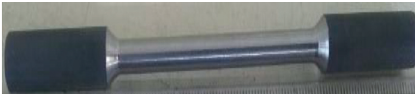
Figure 6: The tensile